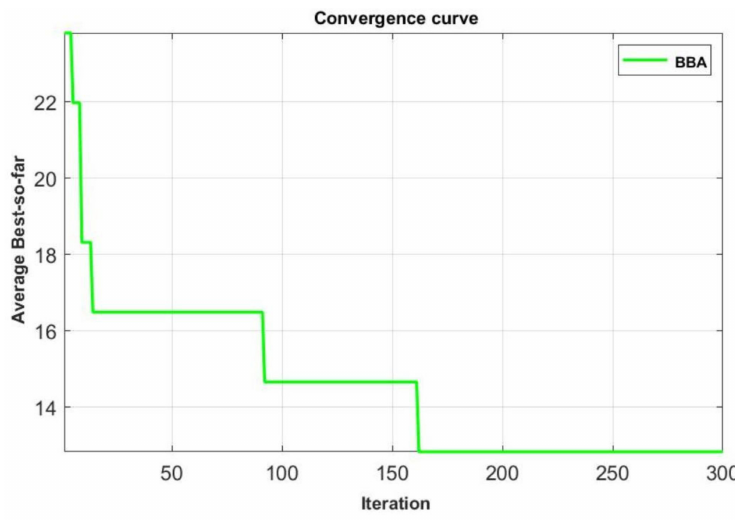
Figure 6. Convergence curve for a single-phase short circuit.